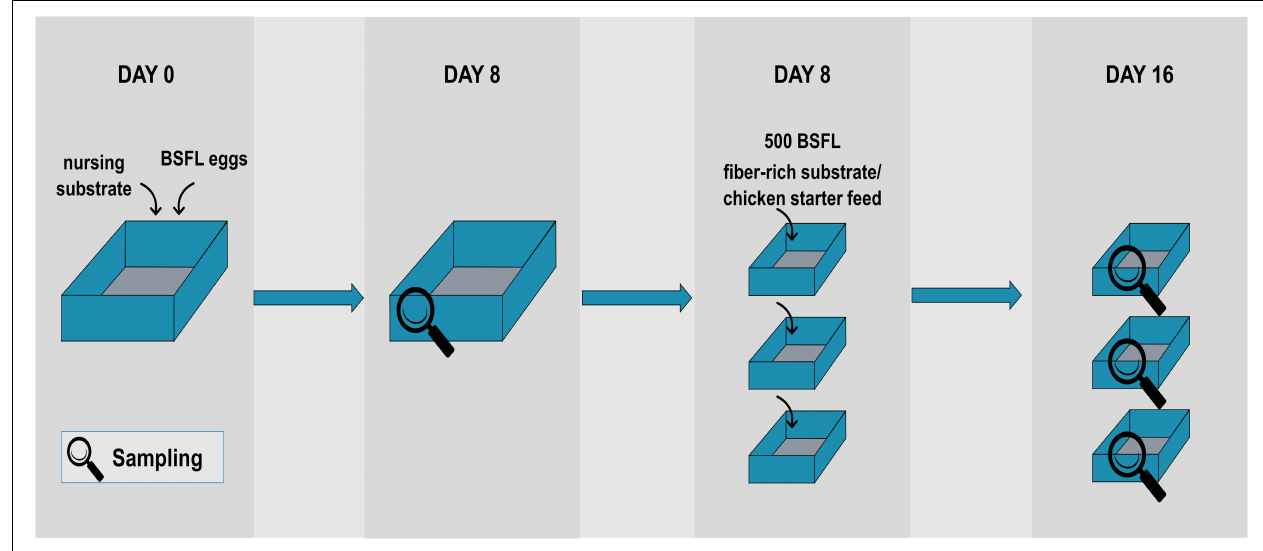
FIGURE 1 | Schematic overview of the rearing protocol used, including the sampling